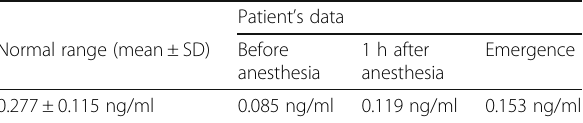
Table 1 Perioperative changes in plasma orexin A concentrations in a narcoleptic patient Patient ’ s data Before